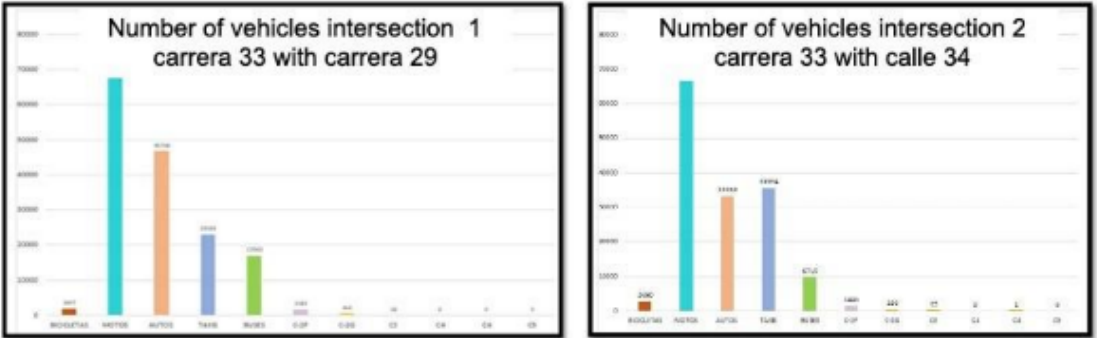
Figure 8: Number of vehicles per week. Each color is associated with a specific means of